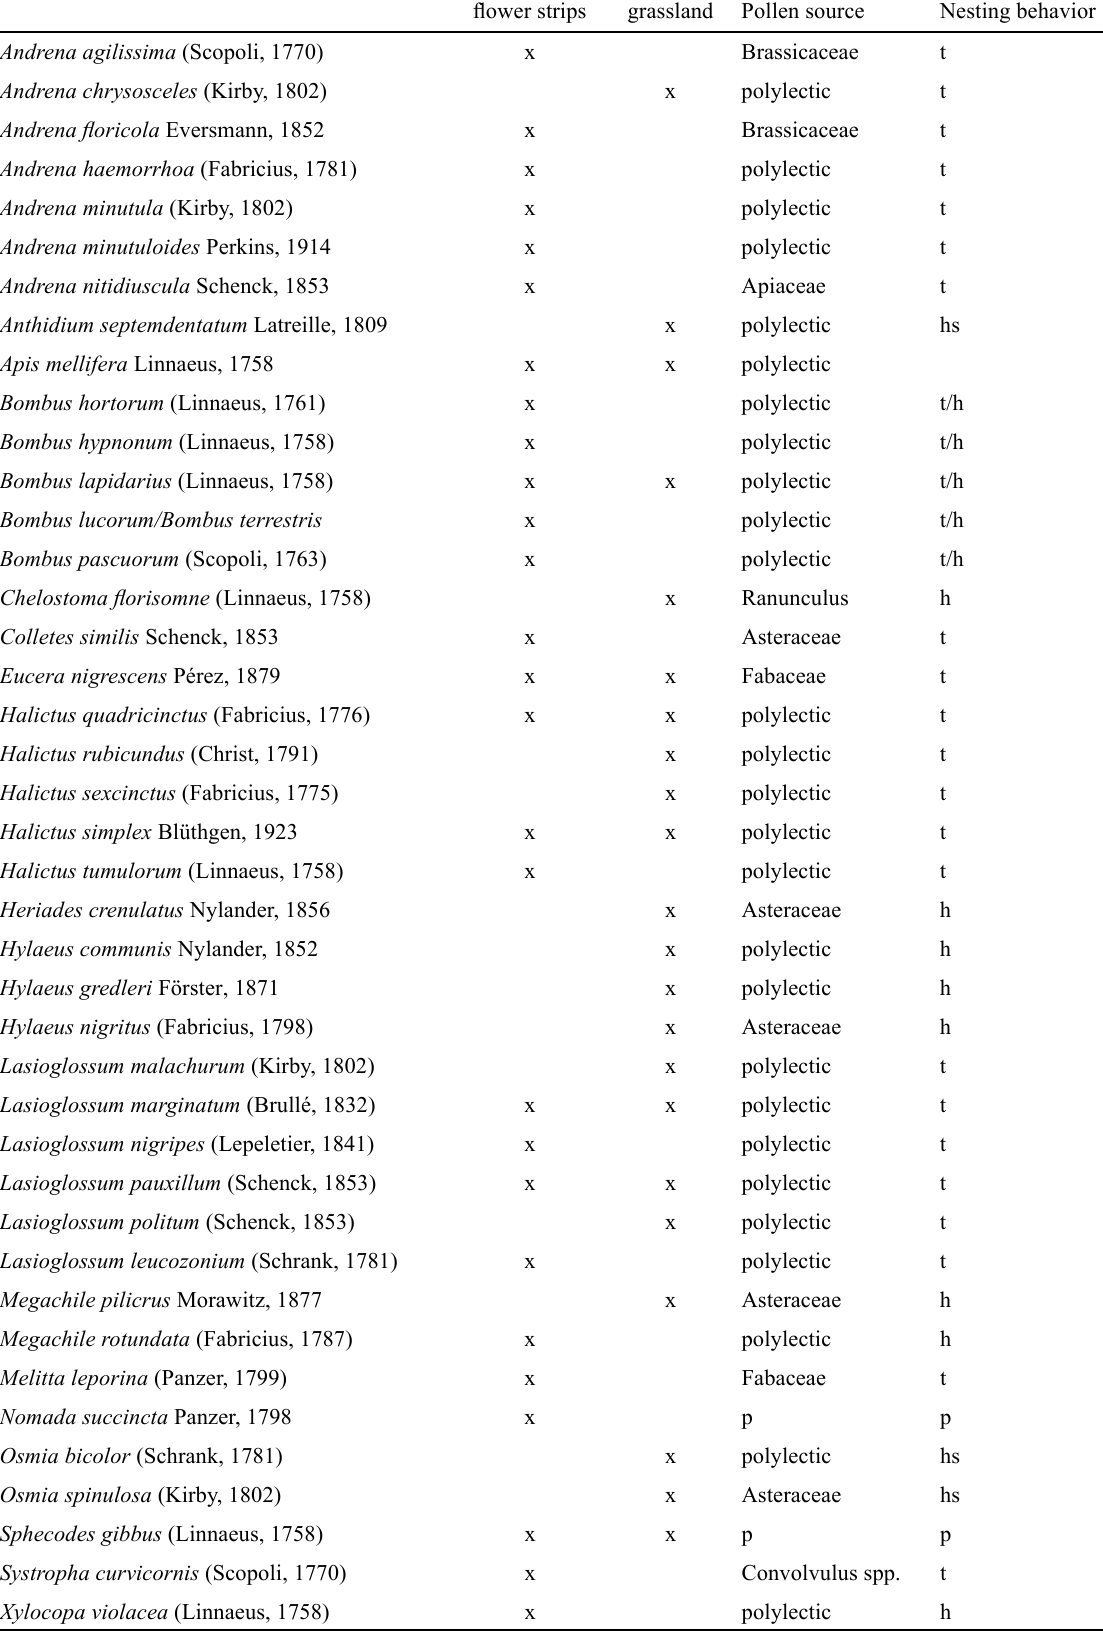
Table 3 . Distribution of bee species (Apoidea) between the habitats (flower strips in vineyards vs. grassland), pollen source and nesting behavior after Scheuchl & Willner, 2016 (p - cleptoparasite, h - cavity breeder, t - ground-nesting, t/h - ground-nesting and cavity breeder, hs - breeding in snail